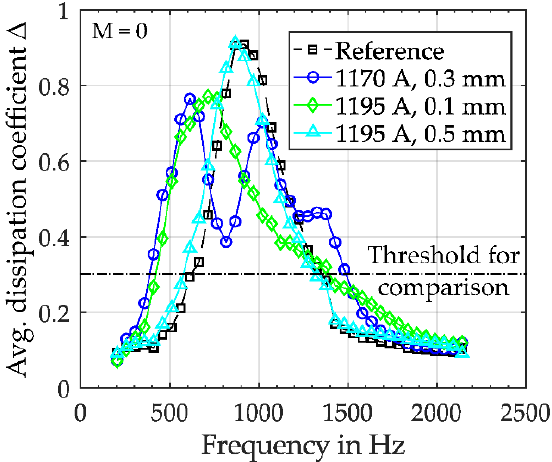
Figure 8. Comparison of the averaged dissipation coefficients for the no flow case ( 𝑀 = 0 ).